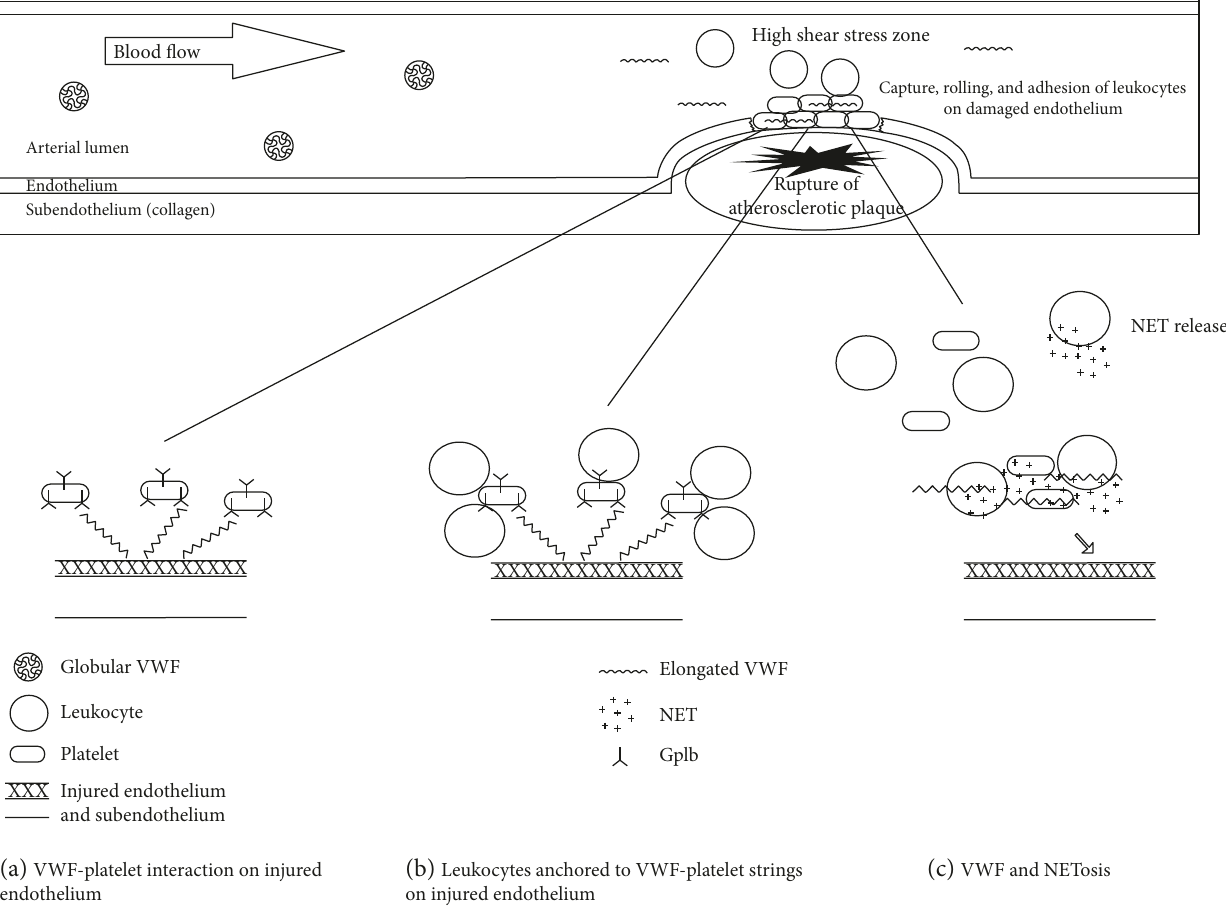
Figure 3: VWF-mediated thromboin fl ammation in high-shear conditions. At high shear rates (e.g., arterioles, microcirculation, and artery stenosis), the inactive globular-shaped VWF rapidly unfolds and elongates in a highly reactive long-chain conformation. The elongated VWF can bind to platelets (a), allowing them to roll and adhere to the damaged endothelial surface. Platelet-decorated UL-VWF strings on activated endothelium represent a solid anchoring matrix for leukocyte adhesion (b), so permitting leukocyte recruitment in the in fl amed site. In the bloodstream, VWF also binds to “ neutrophil extracellular traps ” (NETs) (c), in fl ammatory mediators (decondensed nucleosomes, extracellular DNA, and proteins) released by activated neutrophils, creating a network able to recruit both platelets and leukocytes and to promote thrombus